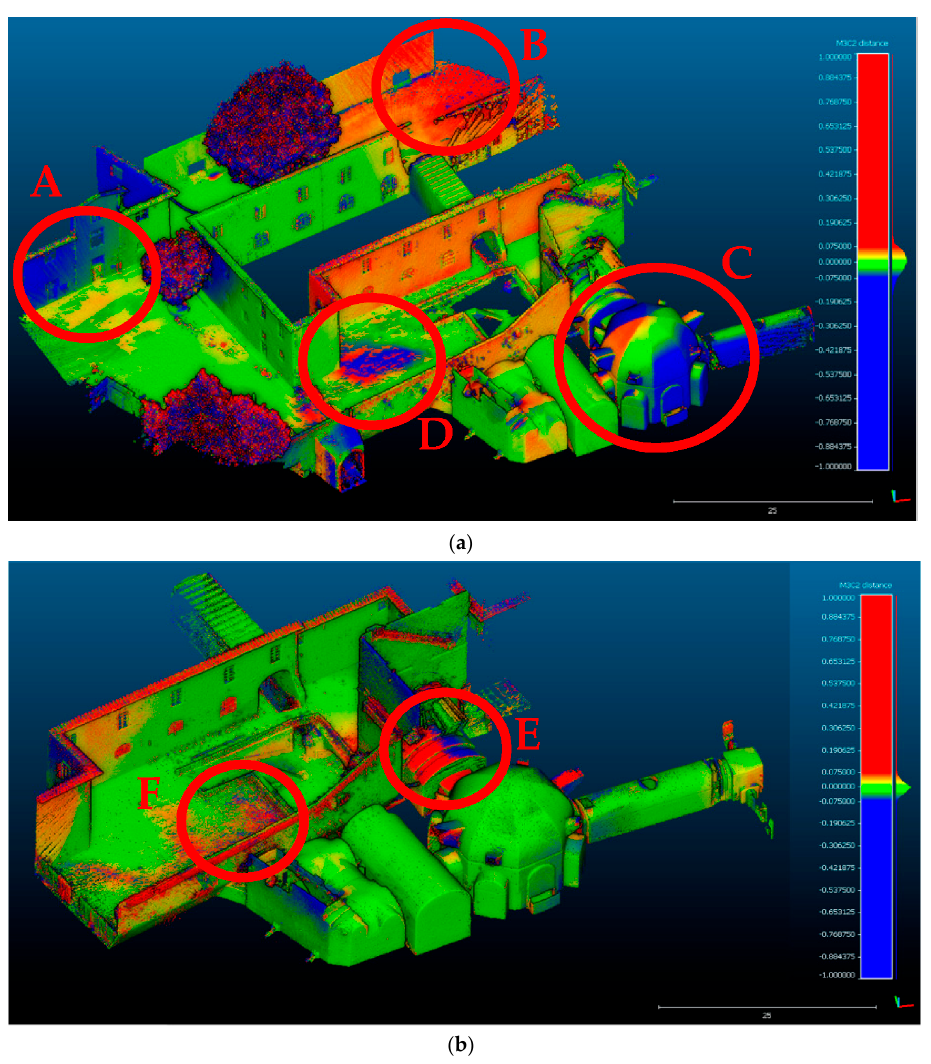
Figure 11. Signed distances of the Leica Pegasus Backpack dataset compared to the ground truth: ( a ) path 1; ( b ) path 2.